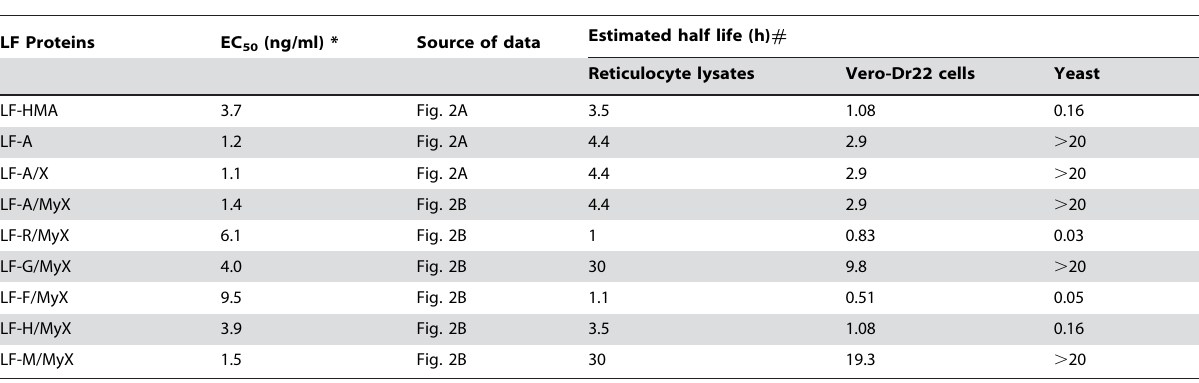
Table 1. Toxicity of LF proteins to RAW 264.7 cells.